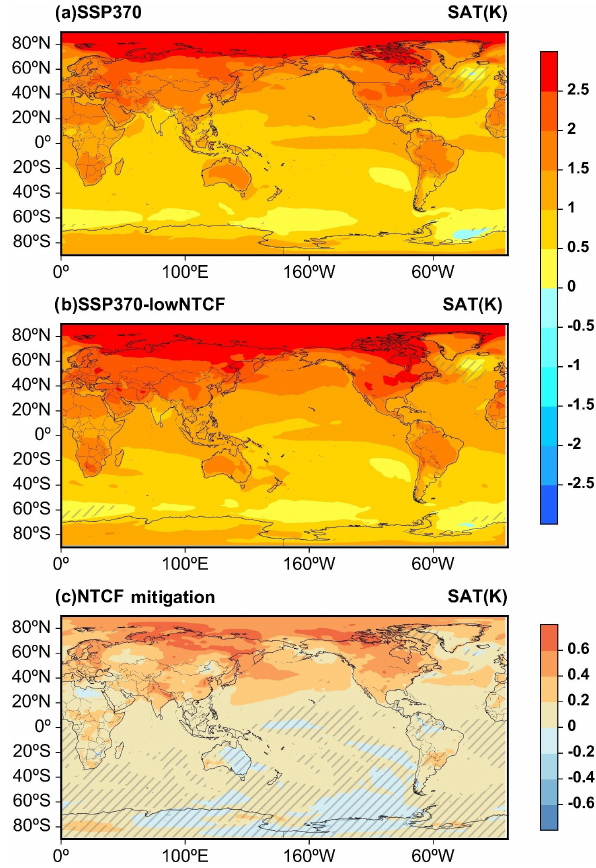
Figure 5. Spatial patterns of changes in surface air temperature (SAT) during 2031–2050 under the (a) SSP3-7.0 and (b) SSP3-7.0- lowNTCF scenarios and (c) SAT only caused by the non-methane SLCF reductions relative to 1995–2014 surface air (units: K). The areas with hatching indicate that at least one out of seven models disagrees on the